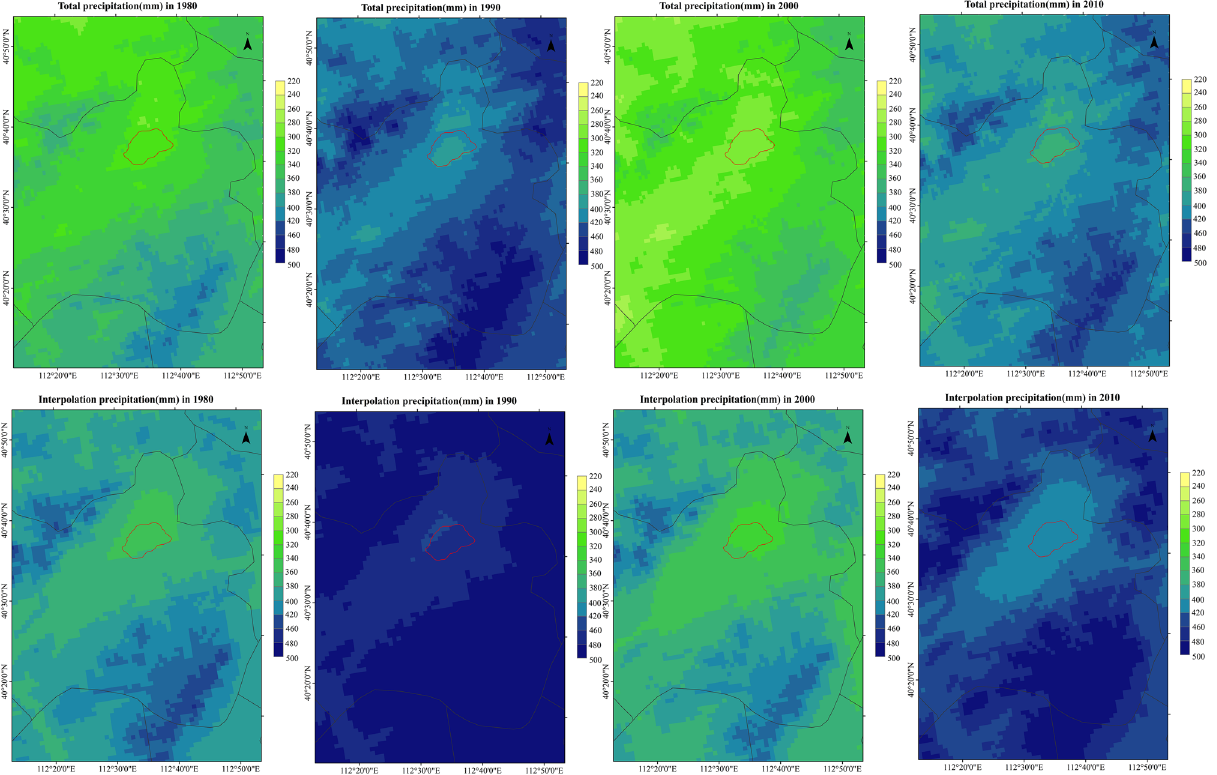
Figure 4. Spatial comparison of WRF-HYDRO simulation and interpolation of annual precipitation in